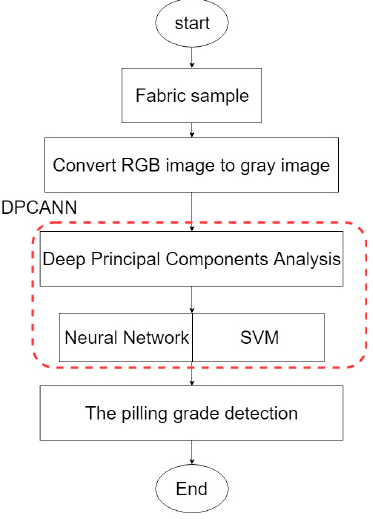
Figure 1. The proposed deep principal components analysis-based neural network (DPCANN) process for fabric pilling